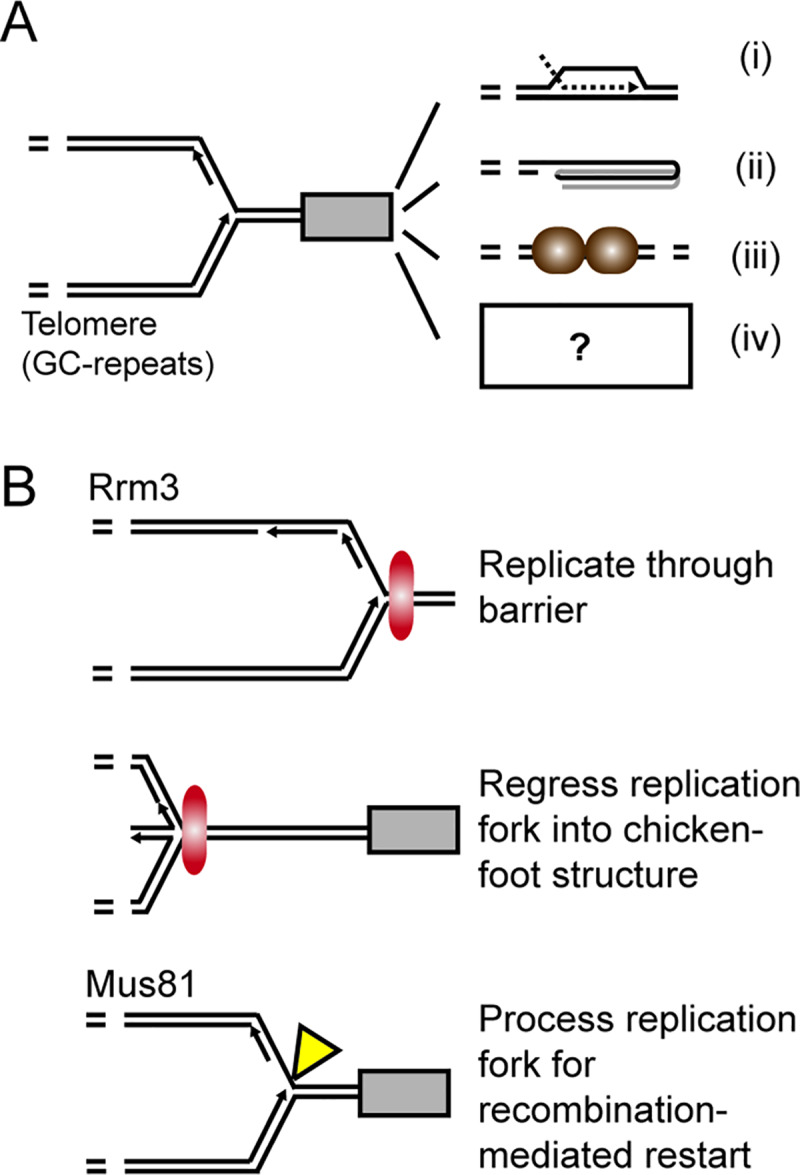
Proposed model of Mus81 involvement at budding yeast telomeres.(A) Telomere sequence and structure presents unique challenges to replication including (i) nucleic acid structures (e.g. t-loop, telomere RNA:DNA complexes), (ii) G-quadruplex structures, (iii) telomere-binding proteins and (iv) yet unknown sources of blockage. (B) Possible mechanisms to rescue stalled replication forks. Rrm3 is a 5’-to-3’ DNA helicase required for normal replication fork progression through ‘hard to replicate’ sequences’ including telomere and subtelomeric regions by directly removing barriers [66, 109]. A second mechanism envisions the regression of the stalled fork into chicken foot that is equivalent to a Holiday junction [110]. Thirdly, Mus81-Mms4 can cleave stalled forks and potentially lead to the formation of a substrate for recombination-mediated repair and restart [110].